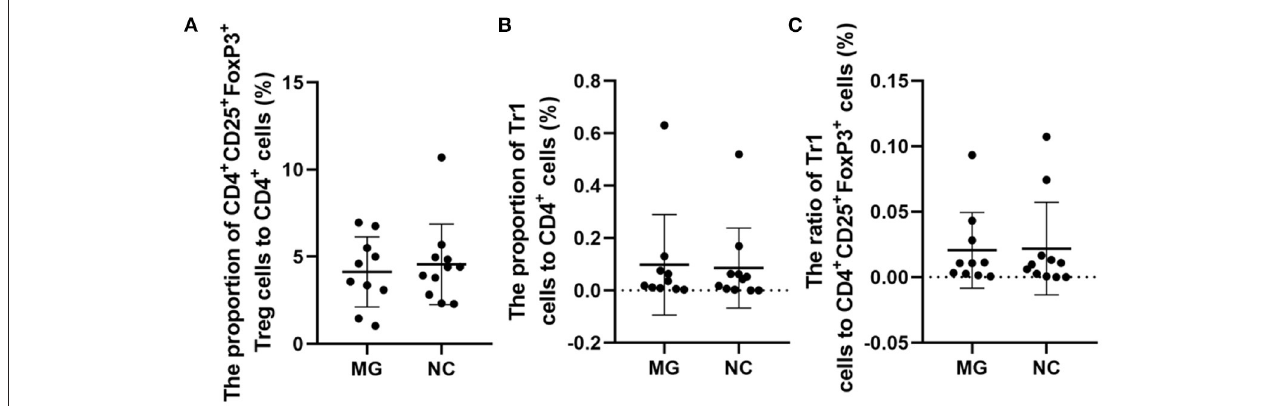
FIGURE 5 | Frequencies of FoxP3 + Tregs in MG patients compared to NCs. (A–C) , no significant differences in the FoxP3 + Treg/CD4 + T ratio, Tr1 Treg/CD4 + T ratio, and the Tr1/FoxP3 + Treg ratio. The data were shown as dot plots with ± SD of each group. N = 10 for MG group and N = 11 for NC group.